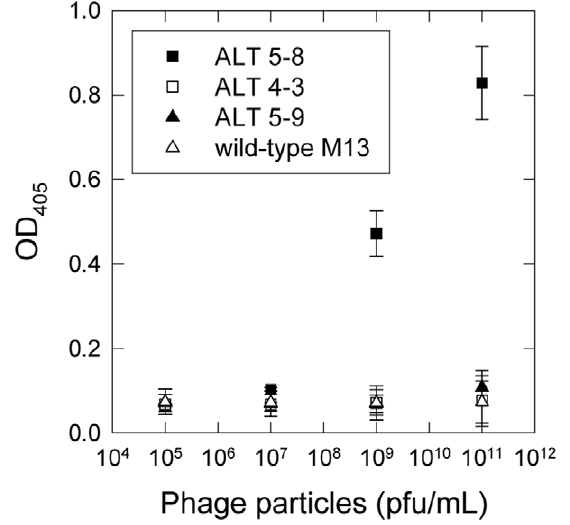
Figure 2. Characterization of the selected ALT binding phage clones using ELISA. ALT binding of the selected phage clones ALT5-8 ( & ), ALT4-3 ( % ), ALT5-9 ( m ) and M13 control phage ( n ) with varying concentrations of phage particles ranging from 10 5 pfu to 10 11 pfu. All measurements were performed in triplicate and error bars represent standard deviations.